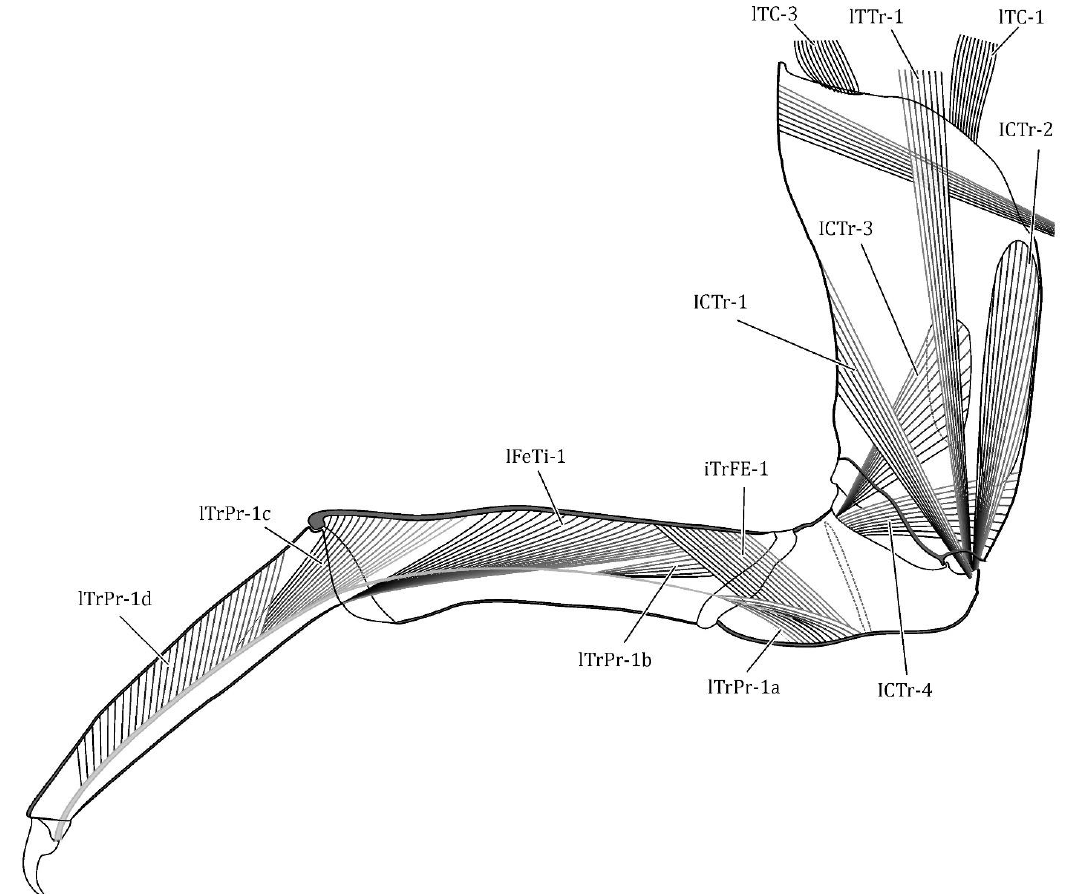
Figure 11. Platerodrilus svetae , female, muscles of the leg. Explanations in text. The leg musculature, excluding muscles originating on the tergite and pleurite, in- cludes 8